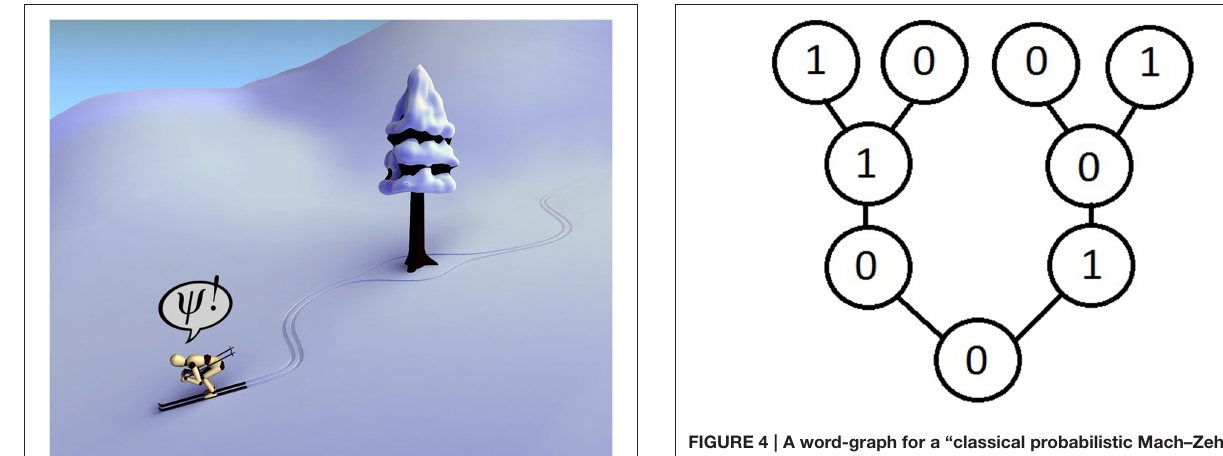
FIGURE 4 | A word-graph for a “classical probabilistic Mach–Zehnder state